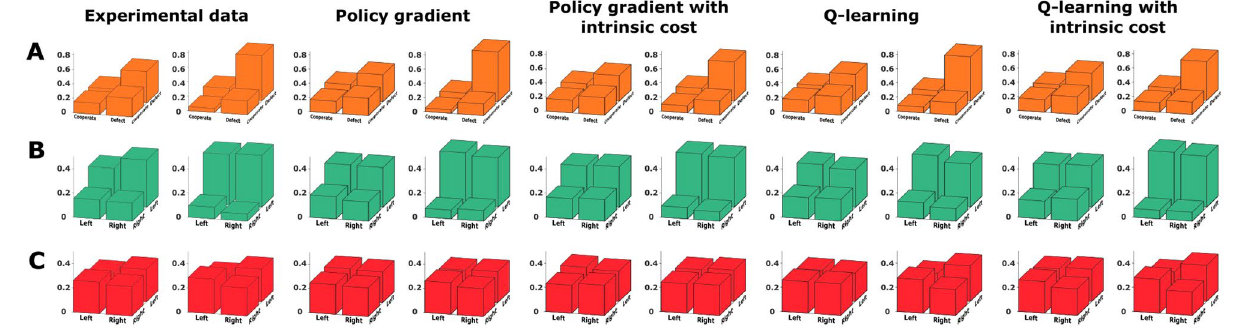
Figure 2. Categorical analysis. Final decisions in the x 1 x 2 -space categorized into two halves for the experimental data (left) and, from left to right, the results of the binary gradient descent, binary gradient descent with prior cost, binary Q-learning, and binary Q-learning with prior cost. We show the first 10 trials compared to the last 10 trials of each block of 40 trials.( A ) Prisoner’s dilemma. ( B ) Asymmetric matching pennies. ( C ) Matching pennies. Created using MATLAB R2021a (https:// www. mathw orks. com) 43